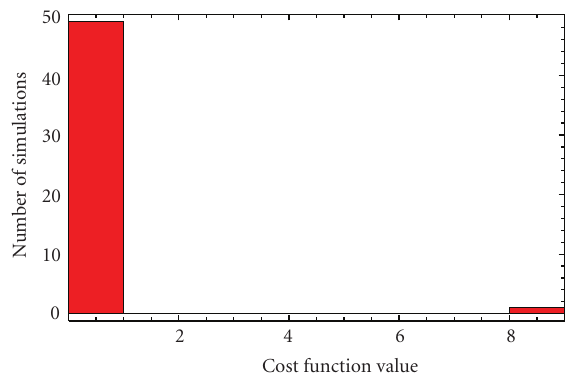
Figure 10: Histogram of DE algorithm: the number of cases in specific intervals of cost function